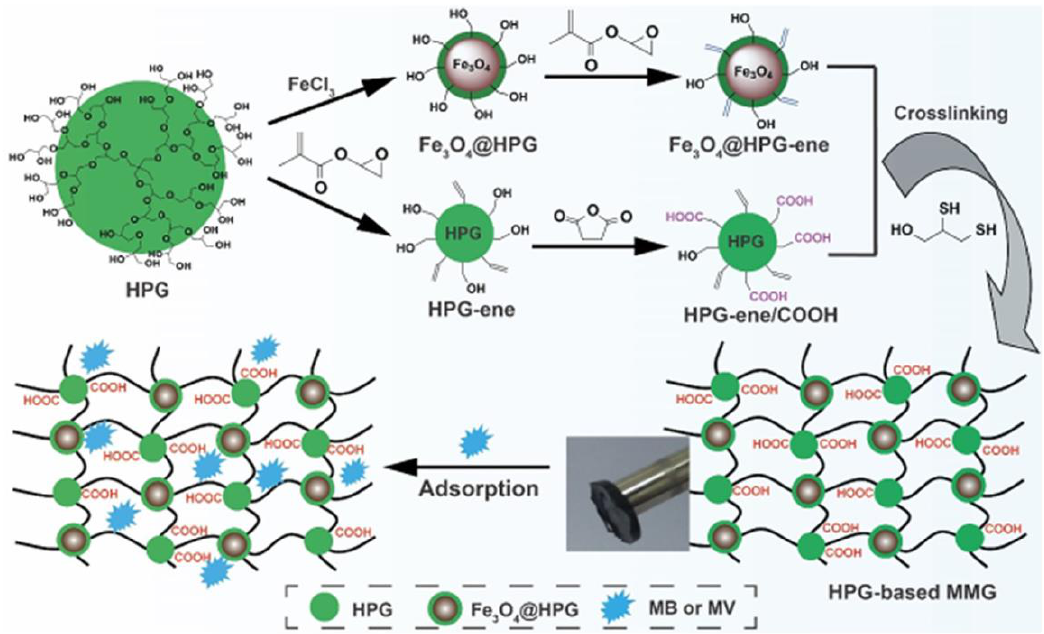
Figure 3. Magnetic hyperbranched polymer for dye adsorption via different interactions. Reprinted from ref. [2] with permission.